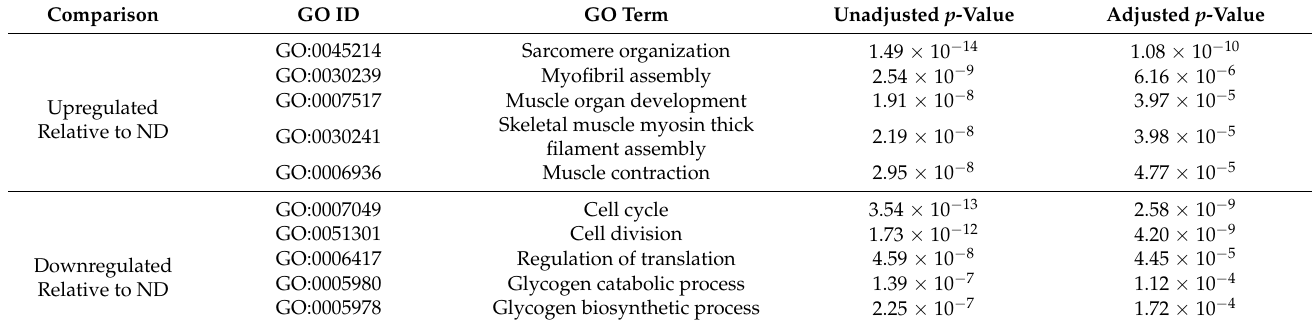
Figure 2. MA plots showing the number of differentially expressed transcripts between each diapaus- ing stage and non-diapause beetles. For each comparison (( a ): ED vs. ND; ( b ): MD vs. ND; ( c ): LD vs. ND), transcripts with FDR < 0.05 are shown in blue. In each panel the total number of up- and downregulated transcripts are indicated. For the full lists of differentially expressed transcripts, see Table S1. ED = early diapause, MD = mid-diapause, LD = late diapause, ND = non-diapause. GO enrichment analysis indicated a total of 106 enriched GO terms among upregulated transcripts and 116 enriched terms at p -value < 0.1 among downregulated transcripts. After clustering semantically redundant terms with REVIGO, most of the enriched BP GO terms in the upregulated transcripts were involved in locomotion (Table 2). For downregulated transcripts, several of the enriched BP GO terms reflect a reduction in protein synthesis and cell division (Table 2). We also ran a contrast to compare gene expression between ED and all the other groups (ND, MD, and LD). Among the genes downregulated in ED relative to all other groups, GO terms related to cell cycle and cell division were similarly enriched (Supplementary Table S2). Table 2. Summary of the GO biological processes that are involved in ED. The table shows GO terms that are significantly enriched among transcripts that are either up- or downregulated during ED relative to ND. The top five up and down enriched GO terms for this comparison are shown. Redundant GO terms were removed using semantic clustering with REVIGO. GO terms that are enriched in the MD vs. ED comparison are shown in Table 3, and a complete list of enriched GO terms can be found in Supplementary Table